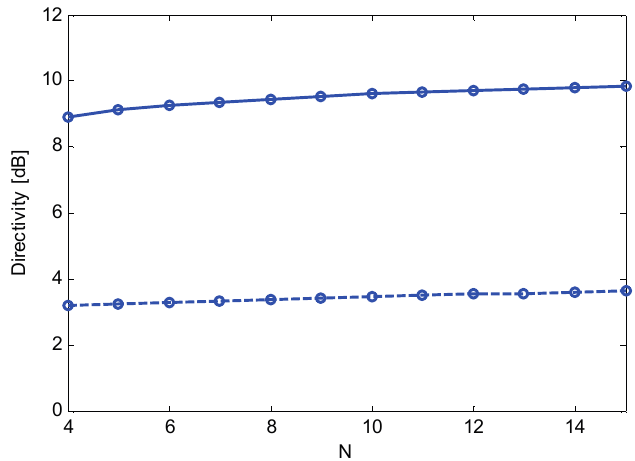
Figure 2. Maximum constrained directivity obtained for an array aperture of D = 0.45 λ versus the number of sensors, N , for end-fire (solid line) and broadside (dashed line) steering; Optimum weights are computed by imposing WNG ≥ 0 dB and solving Equation